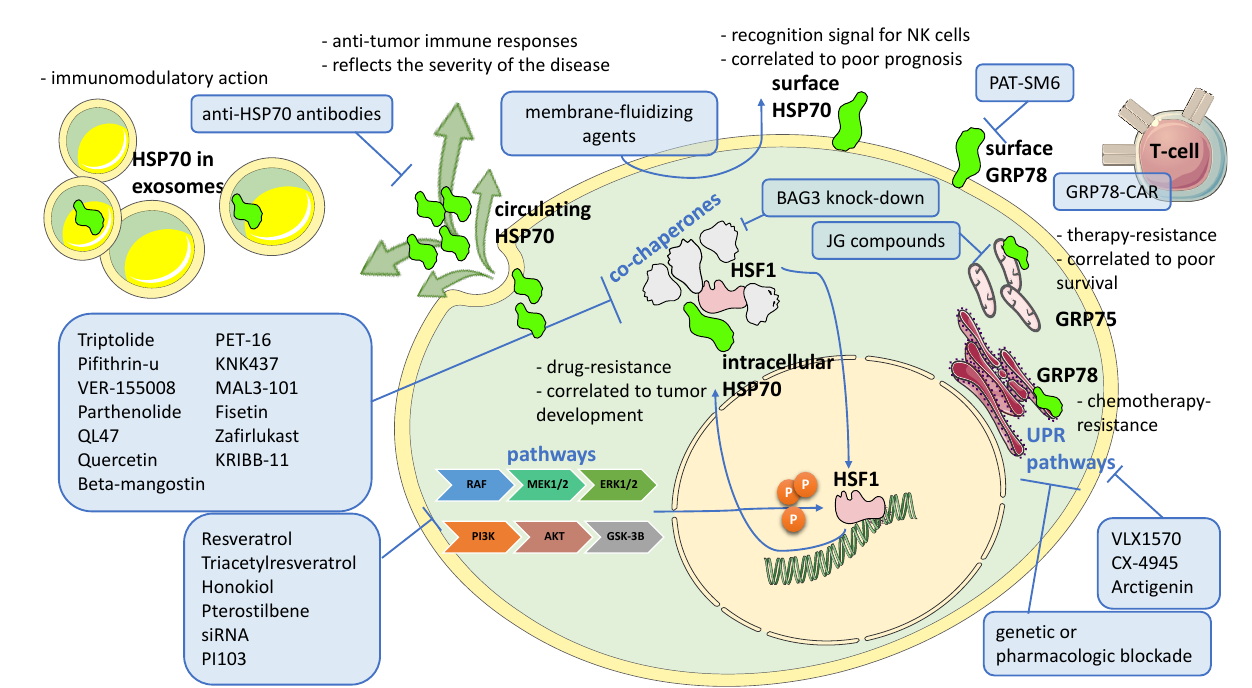
Figure 3. Overview on HSP70 localization, characteristics and proposed targeting. Different forms and localization of HSP70 (green fluorescent objects) are reported, for each of which some charac- teristics are also referred. Inhibitors or agents for HSP70 targeting named in this review, are listed in light blue boxes. Blue connectors are referred to inhibition (T-shaped lines) or promoting mech- anism/activation (arrows). “P” inside orange circles is phosphorylation. CAR = chimeric antigen receptors; UPR = unfolded protein